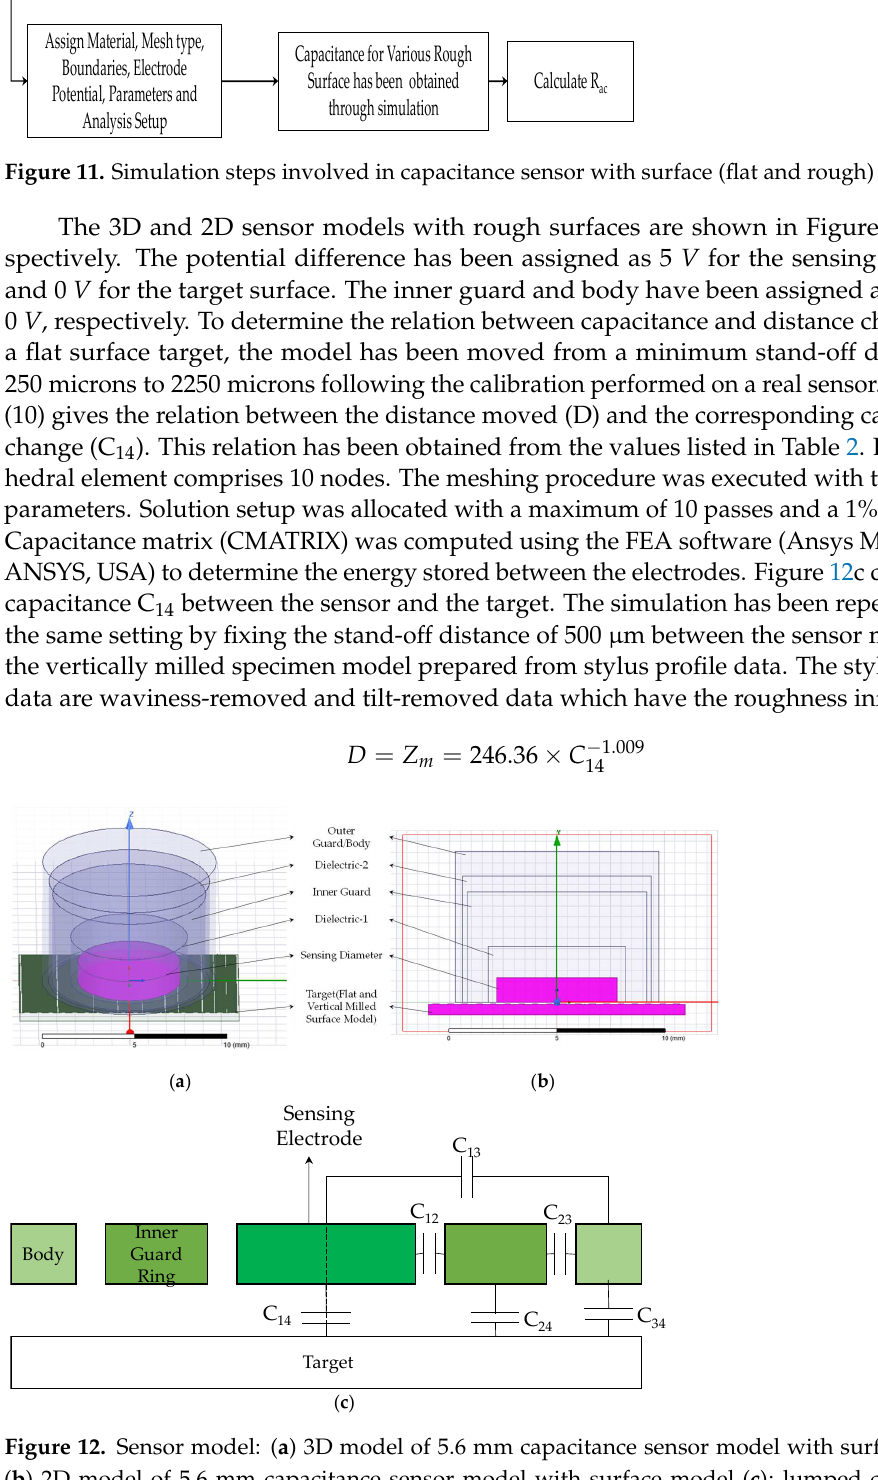
Figure 11. Air has been assigned as the medium between the sensor and the target surface. The inner guard, sensor body, and target material have been assigned as steel.